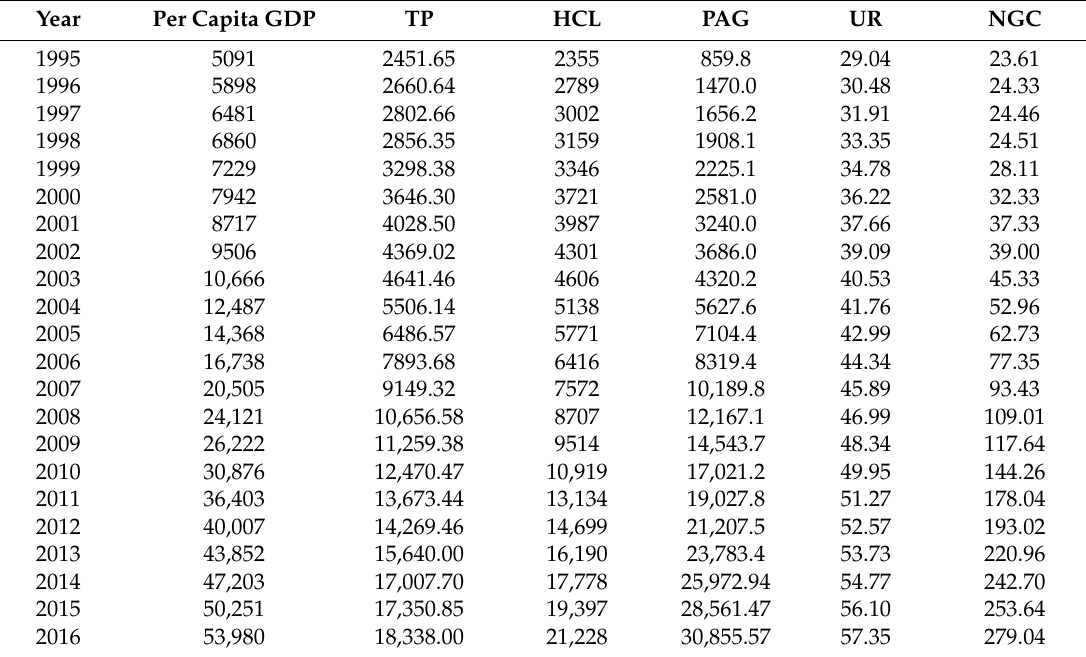
Table 3. Consumption of China’s natural gas and values of affecting factors between 1995 and